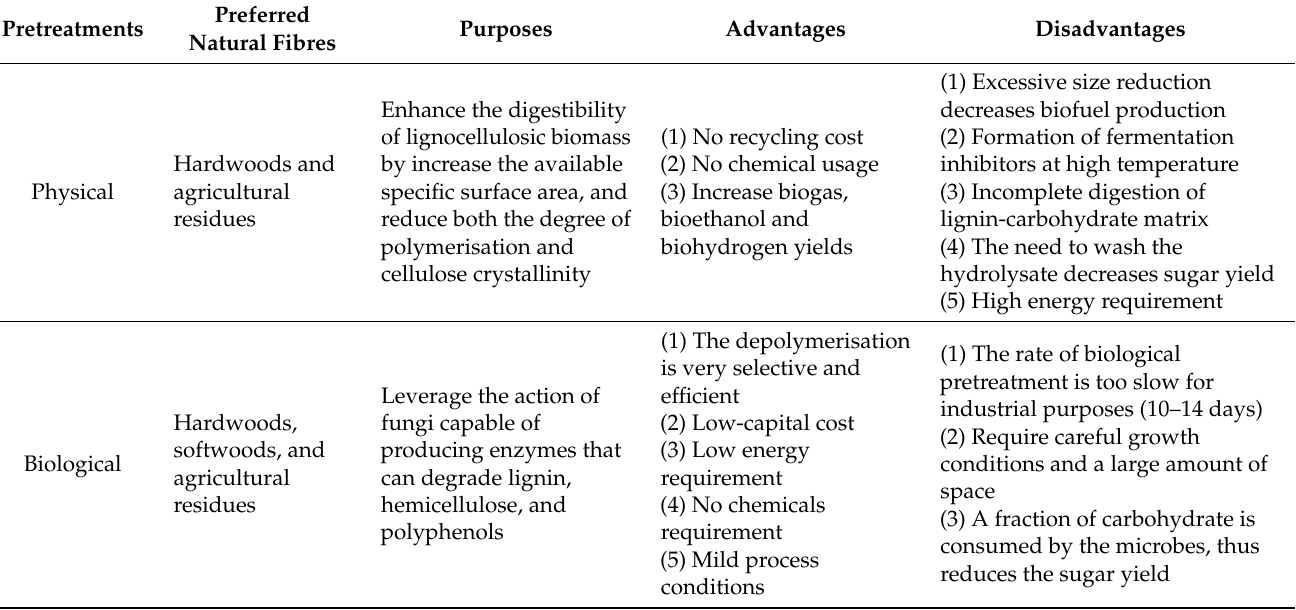
Table 4. Purposes of the pretreatment strategies and their advantages and